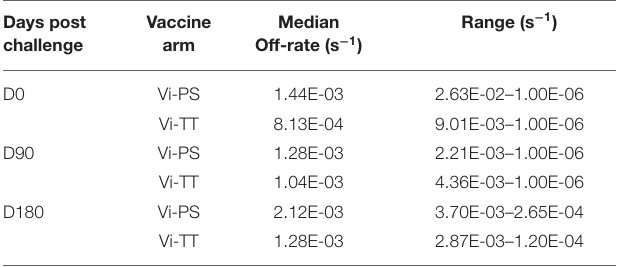
TABLE 4 | Dissociation rates of purified polyclonal IgGs to nViPS. Days post